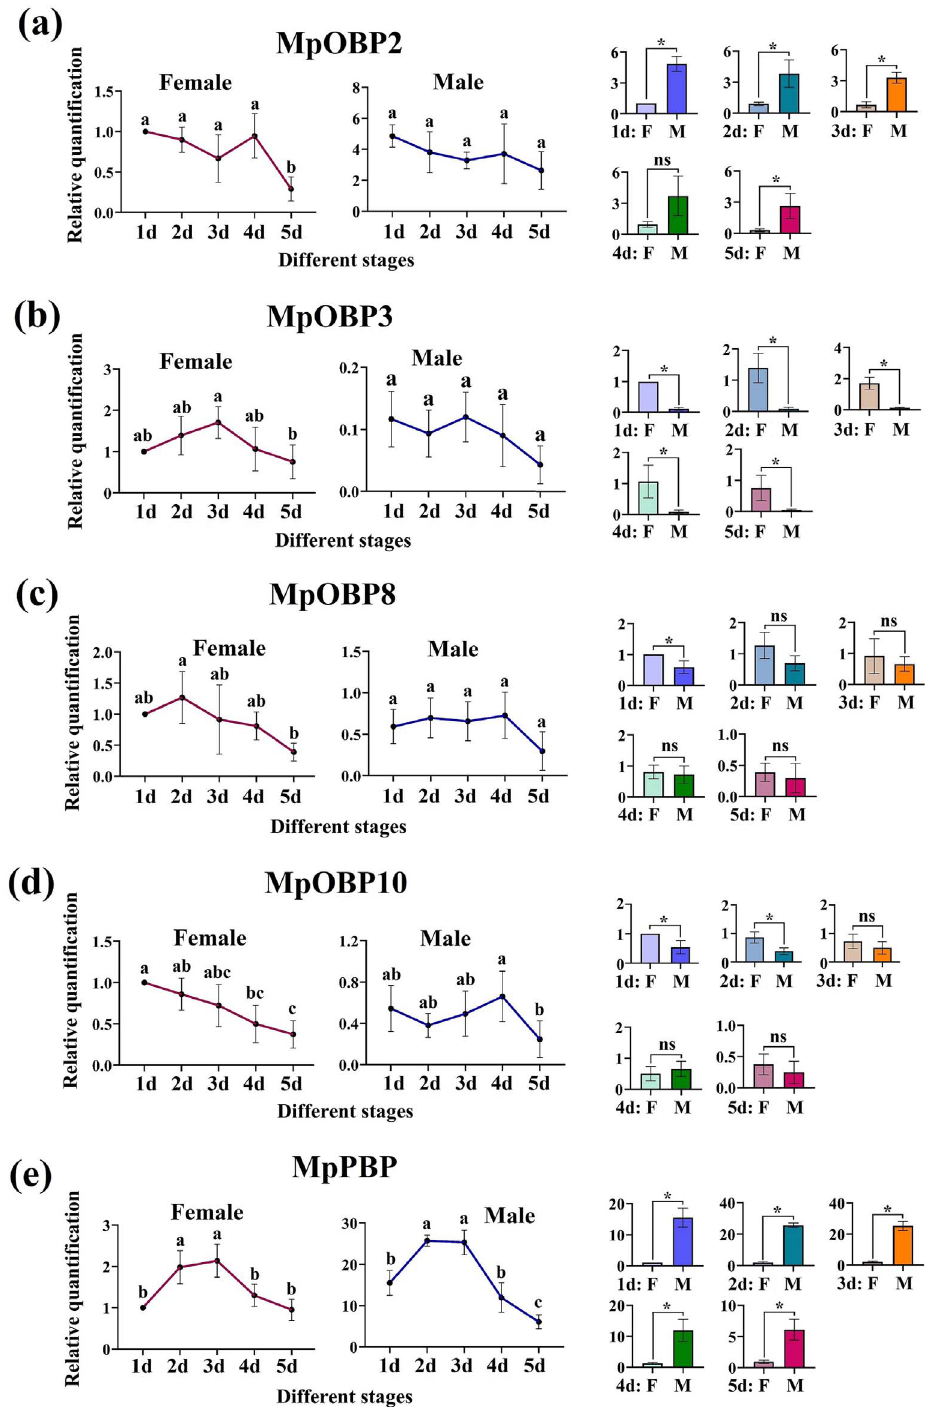
Figure 7. Relative quanti fi cation of M. pallidipes OBPs at different days after emergence to adulthood in female and male wasps. (a – e) MpOBP2 , MpOBP3 , MpOBP8 , MpOBP10 , and MpPBP , respectively. The two charts on the left represent comparisons of OBP expression at different days after emergence to adulthood, and the fi ve small charts on the right represent comparisons of female and male OBP expression. Day or sex is on the x -axis and relative quanti fi cation of M. pallidipes OBPs is on the y -axis. Bars represent standard deviations. 1d – 5d: 1-day- old adults, 2-day-old adults, 3-day-old adults, 4-day-old adults, and 5-day-old adults; F: female, M: male. Different lower-case letters indicate a signi fi cant difference (one-way ANOVA, p < 0.05). ns means no signi fi cant difference and * means a signi fi cant difference ( t -test, p <